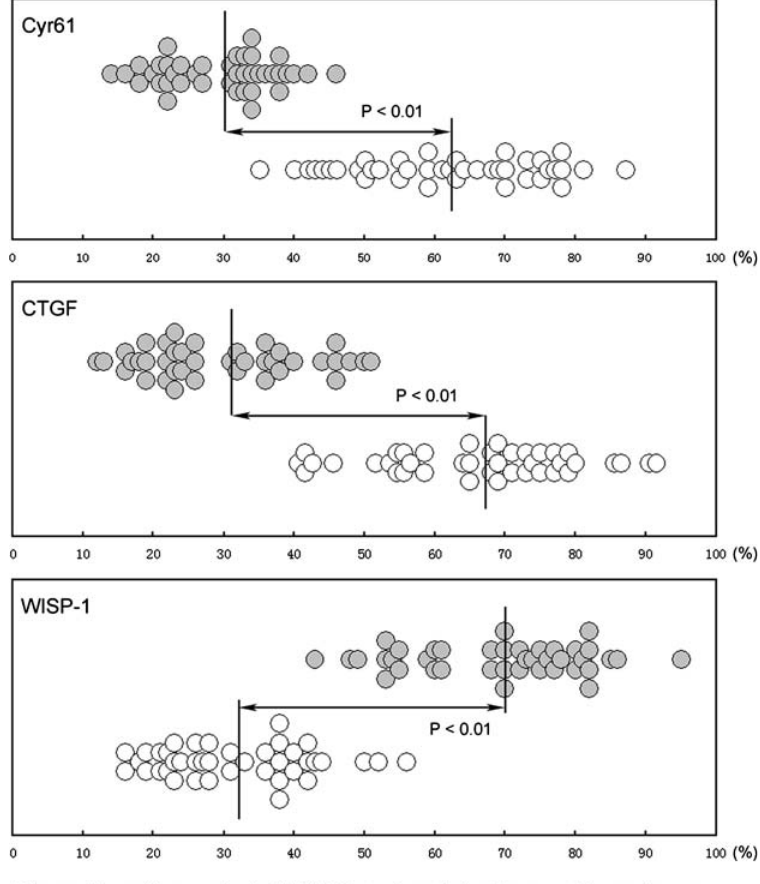
Figure 2. Expression patterns of Cyr61, CTGF, and WISP-1 protein in NSCLC and matched normal lung tissues. The graph depict distribu- tions of specimens according to the percentage of cells positive for Cyr61, CTGF, and WISP-1 in 60 pairs of NSCLC and matched non-cancerous lung tissues. P values (paired-samples t-test) are listed suggesting the difference between NSCLC samples versus matched normal tissues.